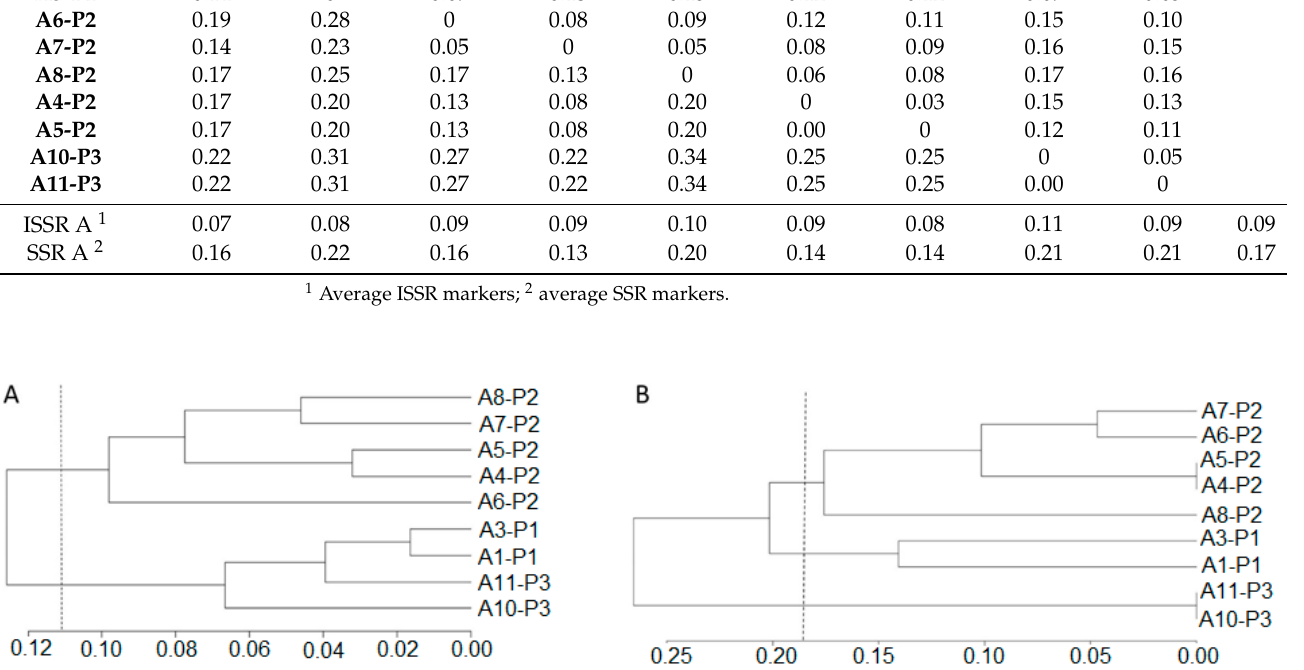
Figure 4. Genetic similarity dendrogram obtained by the UPGMA cluster analysis from ISSR